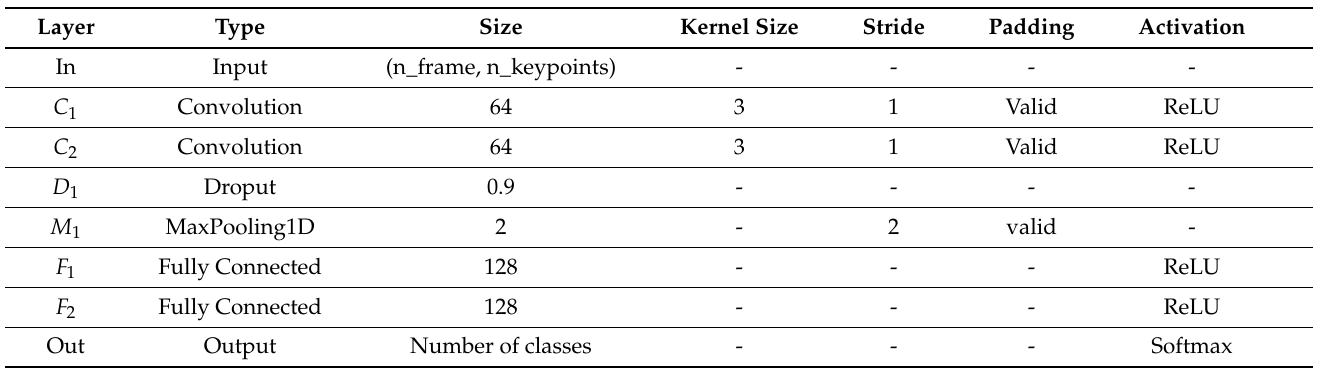
Table 2. 1D CNN model layers &